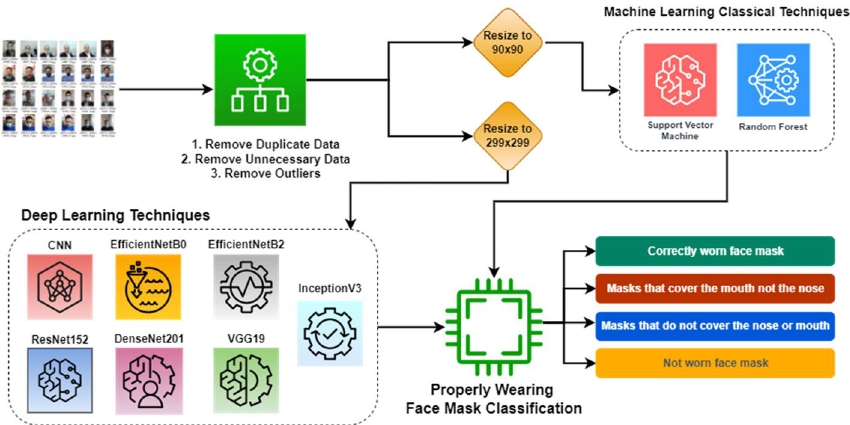
Figure 1. The overall workflow of the proposed system.